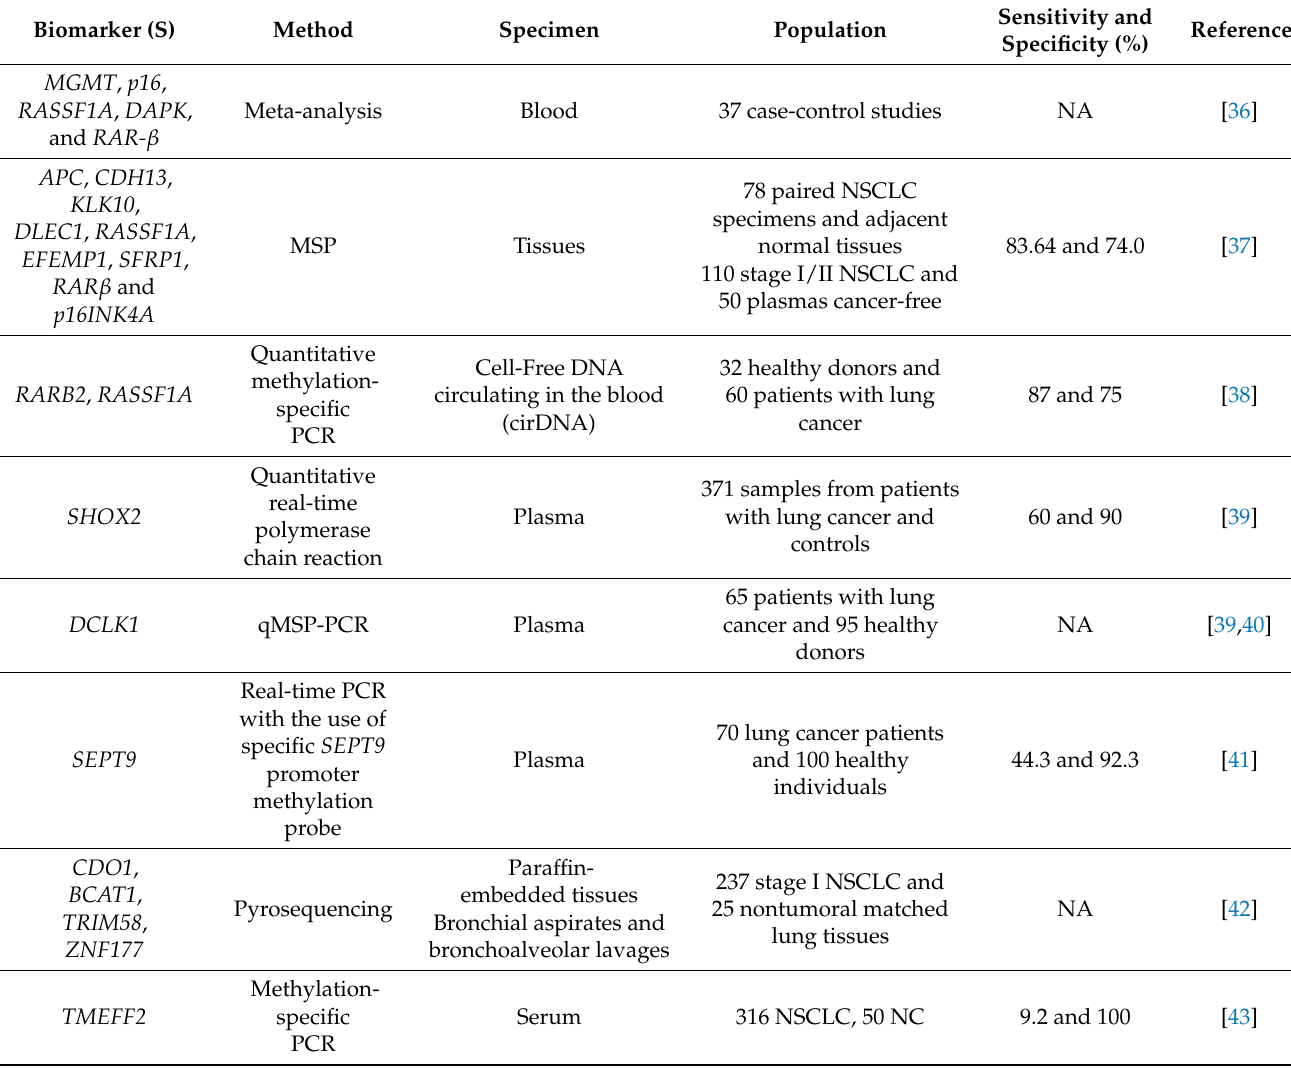
Table 1. Methylation-based biomarkers for early detection of